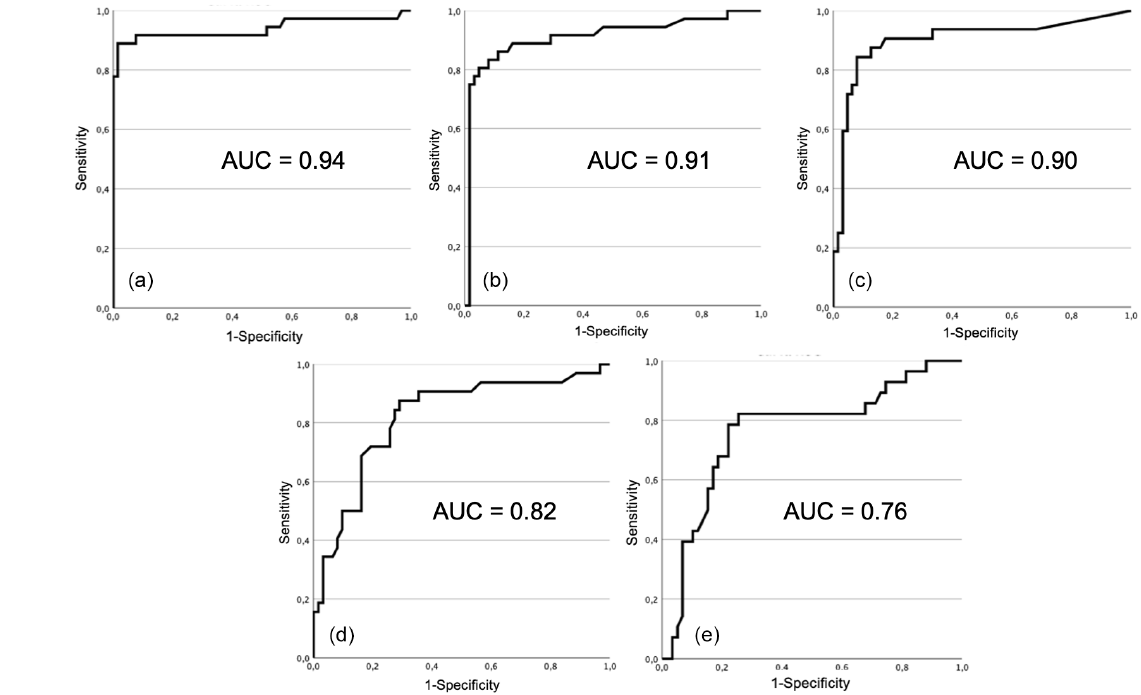
Figure 2. Receiver operating characteristic (ROC) curve and area under curve (AUC) for each test: (a) total leucocyte count, (b) proportion of PMN, (c) synovial fluid CRP, (d) adenosine deaminase, and (e) alpha-2-macroglobulin.